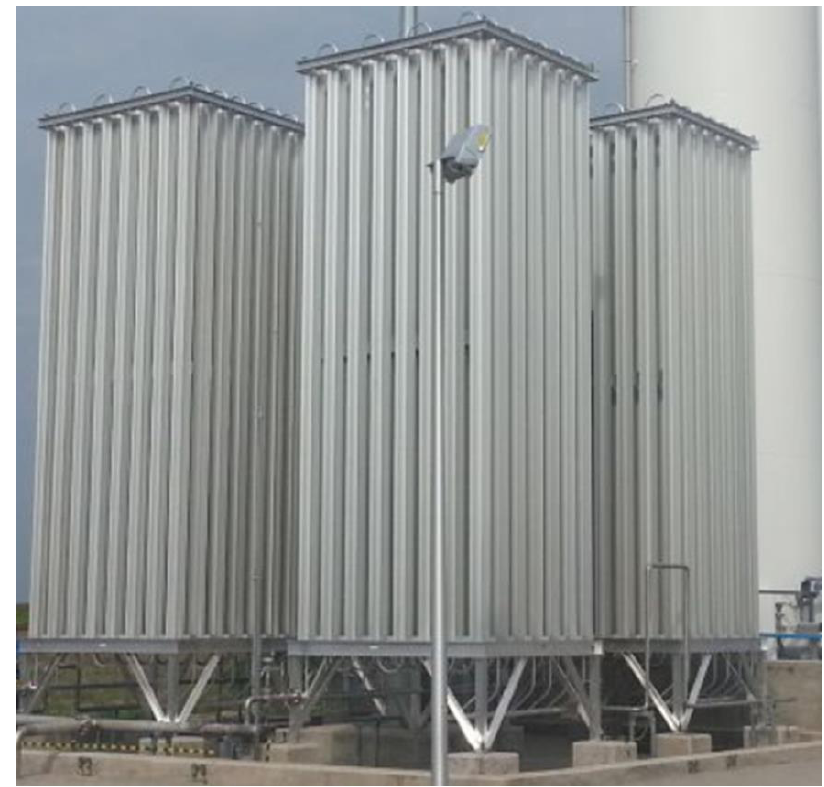
Figure 1. Block of four ambient air vaporizers in LNG regasification station.